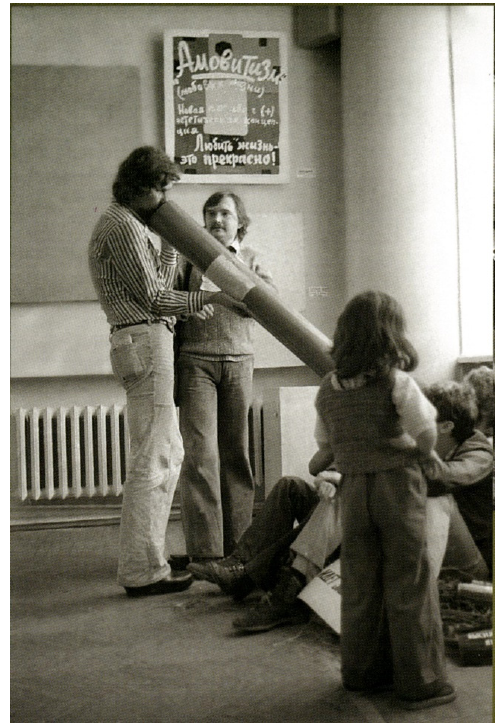
Figure 4. The Nest. Communication Tube . 1975. Galvanized iron, enamel, rubber. 130 cm × 16.5 cm. Installation view. VDNKh exhibit, Moscow. Image courtesy of Victor Skersis. Photograph by Igor Palmin.